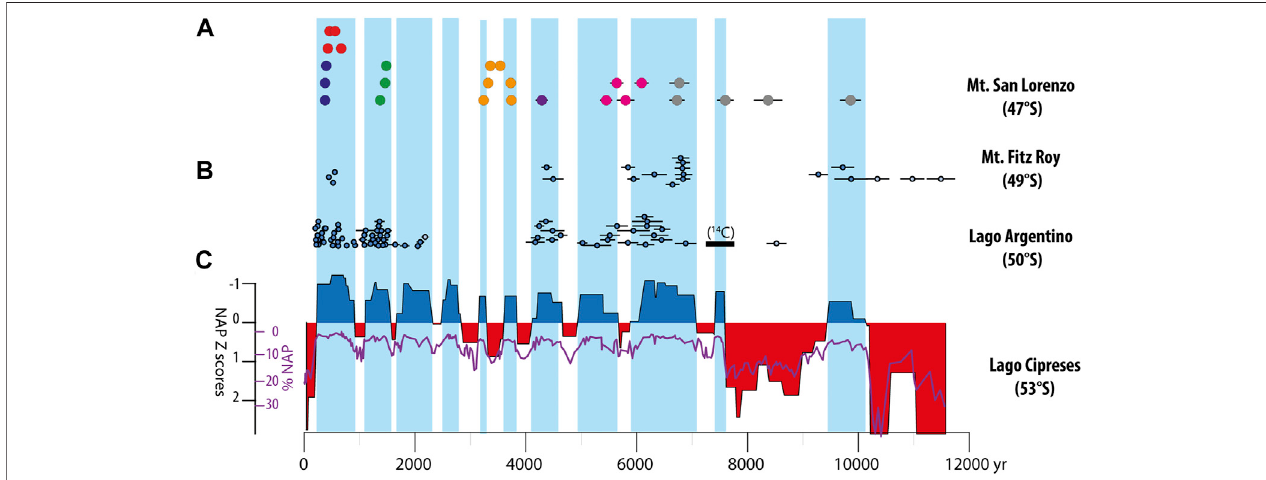
FIGURE 5 | Holocene glacier 10 Be chronologies from Patagonia. (A) Individual ages ( ± 1 σ ) on moraine ridges in the Río Tranquillovalley; circles with the same color correspond to samples on the same moraine ridge, including correlated crests between right and left laterals on either side of the valley (same color as in Figures 3 , 4 ). For samples < 4,000 years, the error is smaller than the symbol. Events are found between 9,860 ± 180 and 6,730 ± 130, at 5,750 ± 220, 4,290 ± 100 (?), 3,490 ± 140, 1,440 ± 60, between 670 ± 20 and 430 ± 20and fi nally at 390 ± 10 years (B) Individual ages ( ± 1 σ ) on moraine ridges in the Torre valley (Reynhout et al., 2019) and Lago Argentino basin (Strelin et al., 2014; Kaplan et al., 2016). Also, we show a glacier advance between 7.7 and 7.2 ka, detected with 14 C dating of wood in a stratigraphic section (Strelinet al.,2014) but notwith 10 Be agesfor themoraine record. (C) Coldand wet(blue)and warm and dry periods (red) asshown by regimeshift detection analysis of non-arboreal pollen (NAP) record from Lago Cipreses at 51 ° S (Moreno et al., 2018). Negative (positive) values correspond to periods of strong (weak) and northward (southward) displaced SWW. We also included the percent of NAP (purple line). To facilitate comparisons with the glacier records, we included blue vertical shading representing the cold and wet